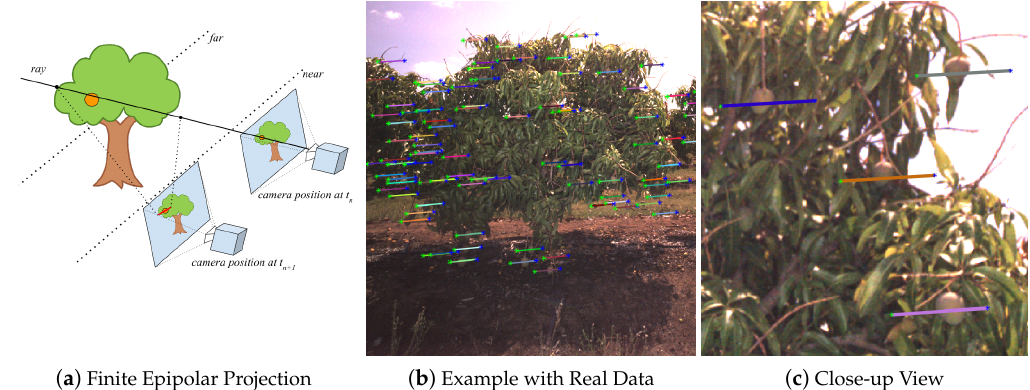
Figure 5. An illustration ( a ) of how epipolar line segments were calculated. A ray is projected from the camera centre corresponding to the first image at t n , through the location of a mango in the image-plane. The ray is clipped at two distances (constant for the whole orchard). The start and end points of the ray are then projected into the second image-plane at t n + 1 . An example with real data is shown in ( b ) with a close-up in ( c